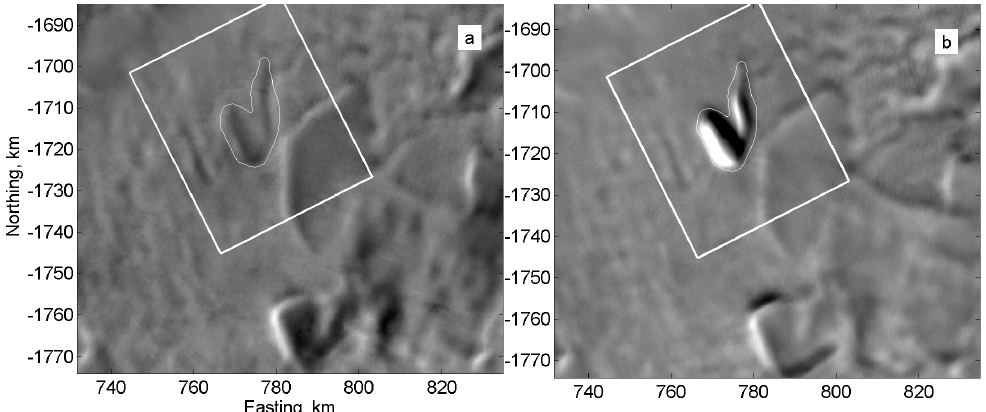
Fig. 10. Subset of the MODIS Mosaic Of Antarctica (Scambos et al., 2007) around the region of Lake Cook E2 . (a) The 2003–2004 mosaic and (b) 2008–2009 mosaic processed with the same algorithm (T. Scambos, personal communication, 2013). This subset corresponds to the dashed line box in Fig. 1b. The white box is the zone covered by Fig. 4. The white thin contour is the − 3m contour extracted from the map of elevation difference from DEMs, our preferred estimate of the lake area (Fig.